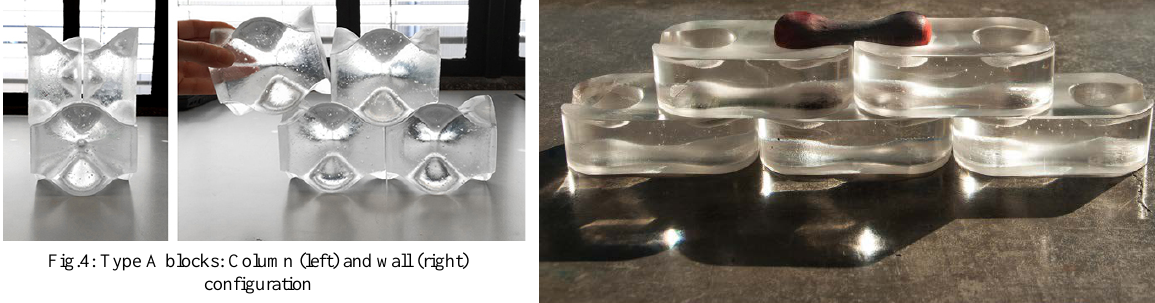
Fig.4: Type A blocks: Column (left) and wall (right) configuration